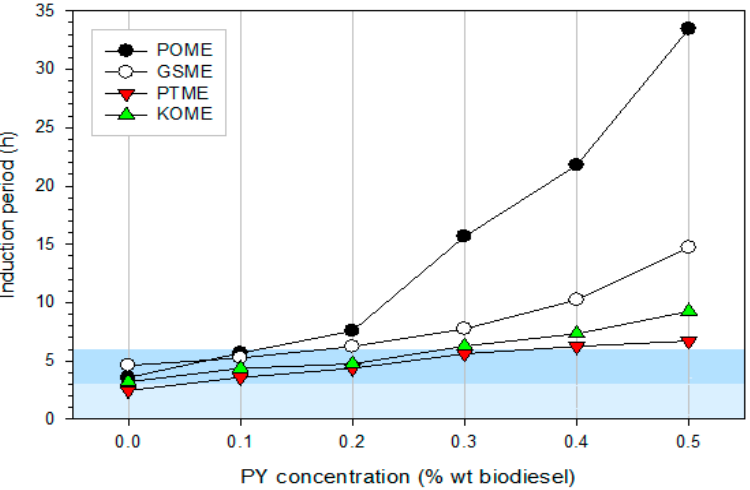
Figure 1. Effects of different pyrogallol (PY) concentrations on the oxidation stability of biodiesel. Figure 1. E ff ects of di ff erent pyrogallol (PY) concentrations on the oxidation stability of biodiesel.